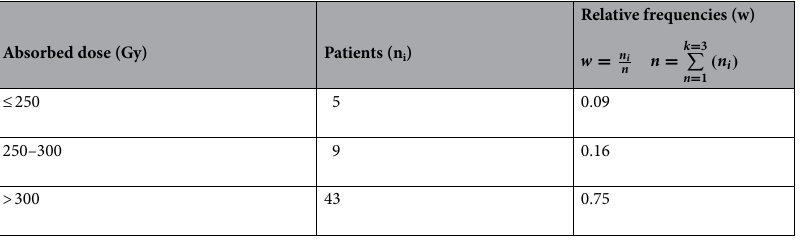
Table 2. Number of patients treated with 131 I ranked according to 131 I absorbed dose in remnant thyroid after surgical treatment—an interval frequency distribution